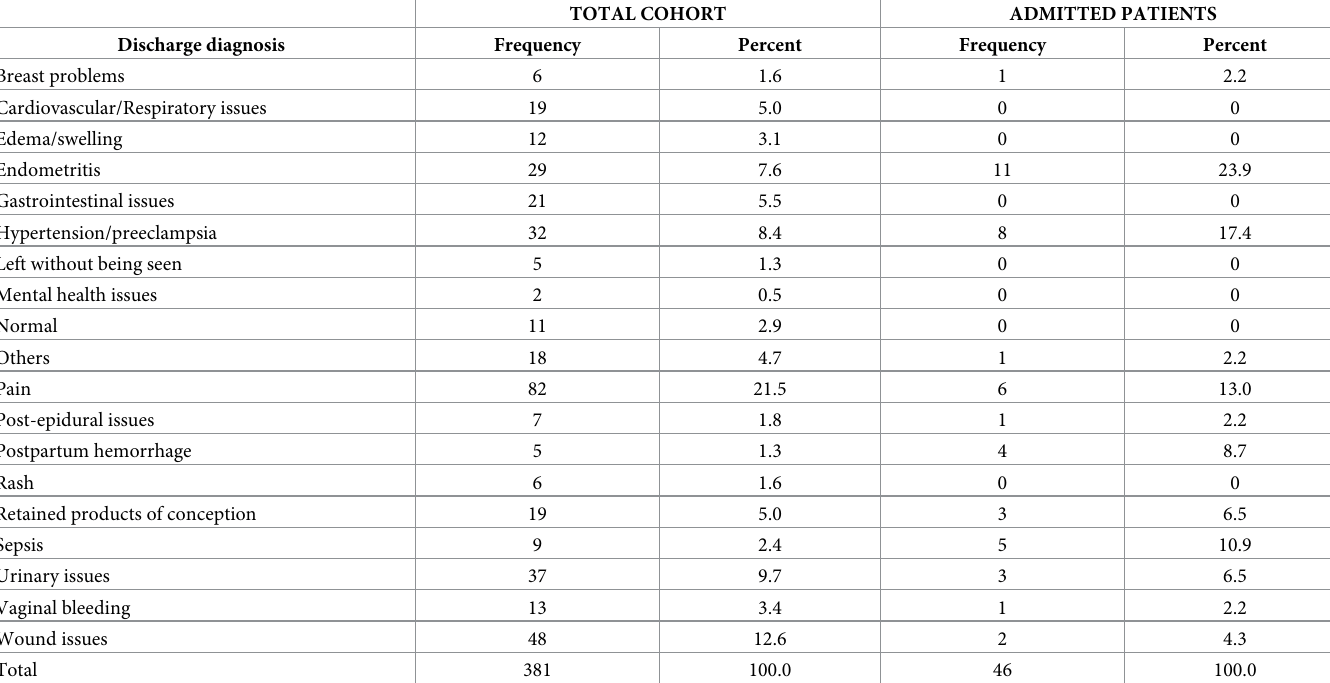
Table 3. Frequency and percentage of discharge